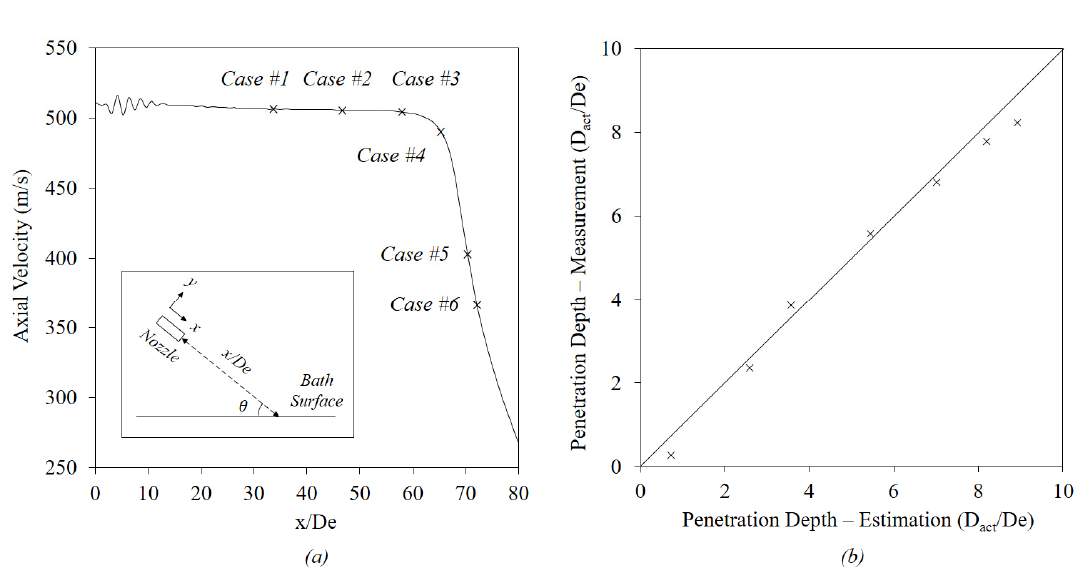
Figure 7. ( a ) Different nozzle-liquid surface distance for specific burner configuration; ( b ) Parity plot of penetration depth inside liquid steel bath.